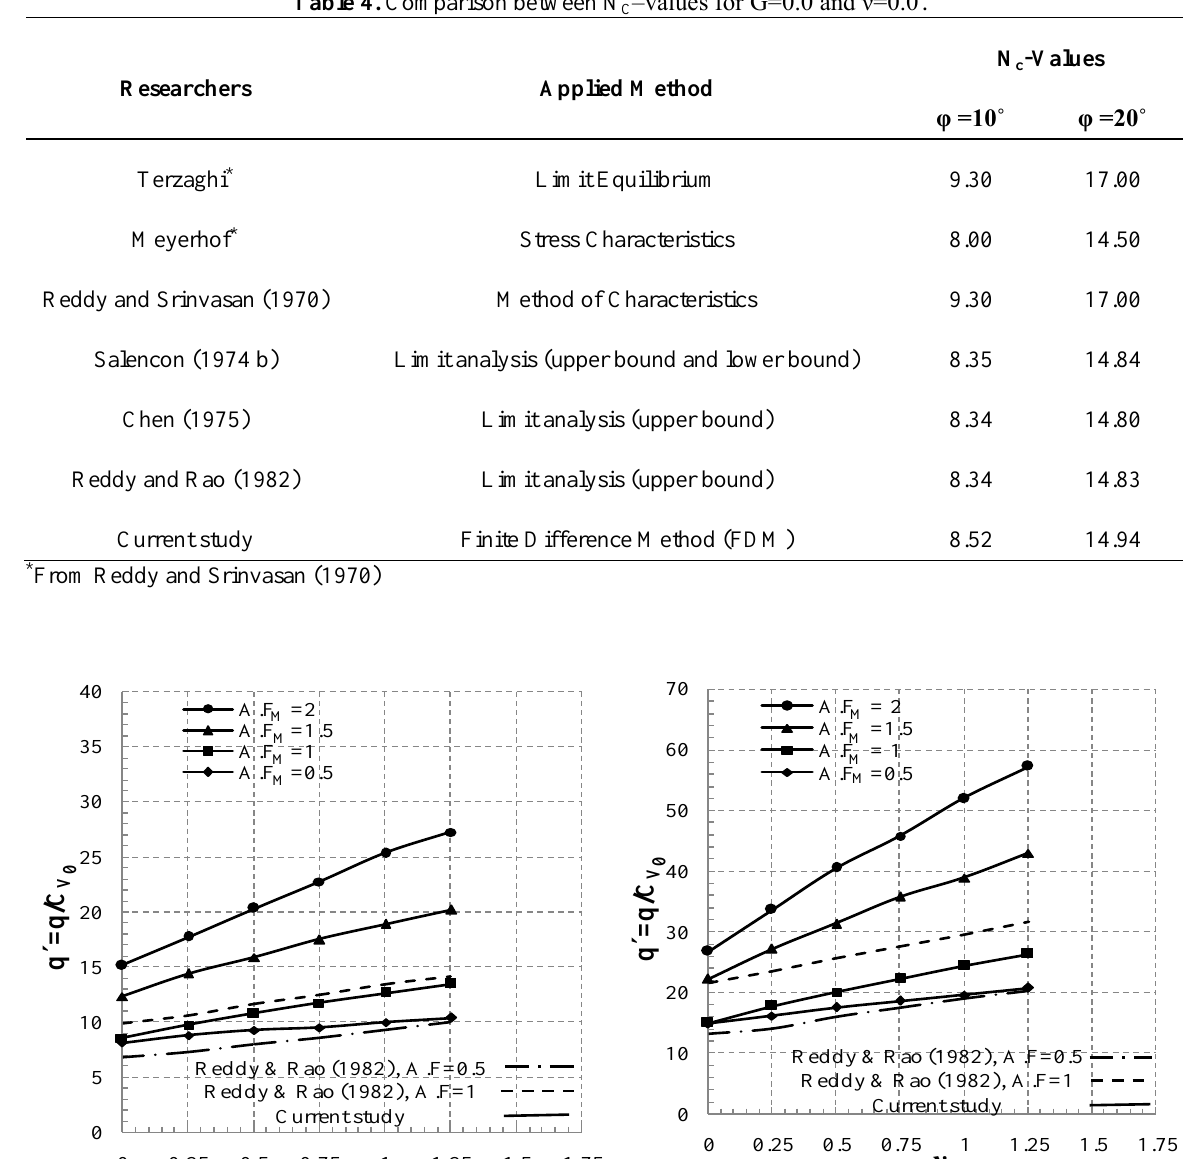
values at; a) φ=10˚and b) φ=20˚.